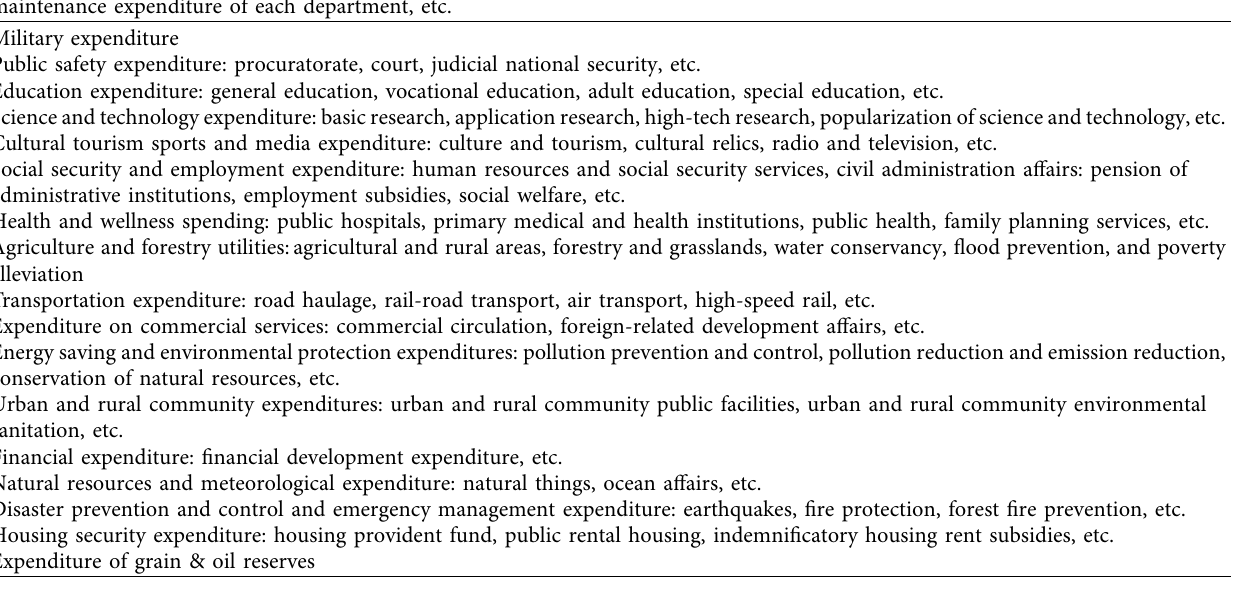
Table 1: Questionnaire